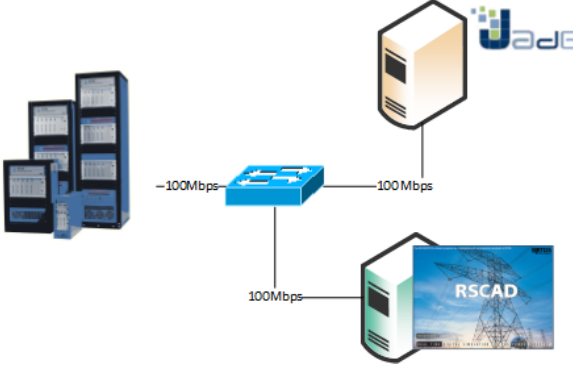
Figure 2. Real-Time Framework Topology.